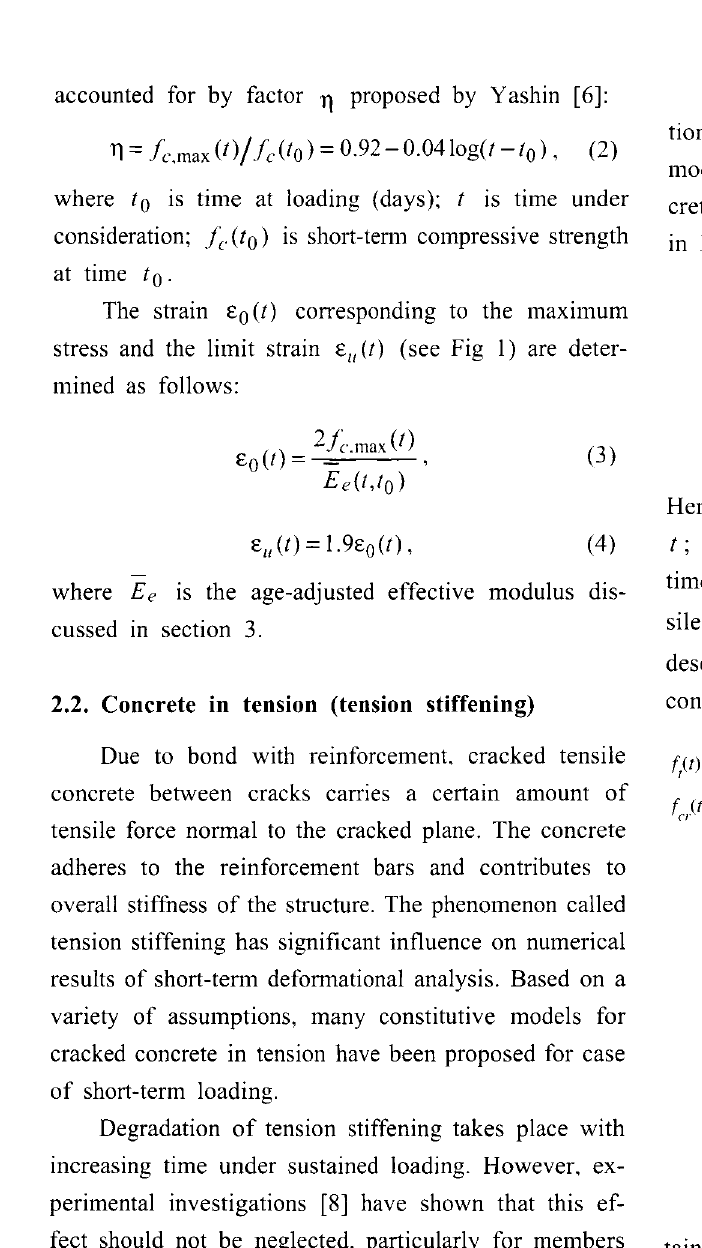
Fig 2. Modified stress-strain relationship for cracked concrete in tension under long-term